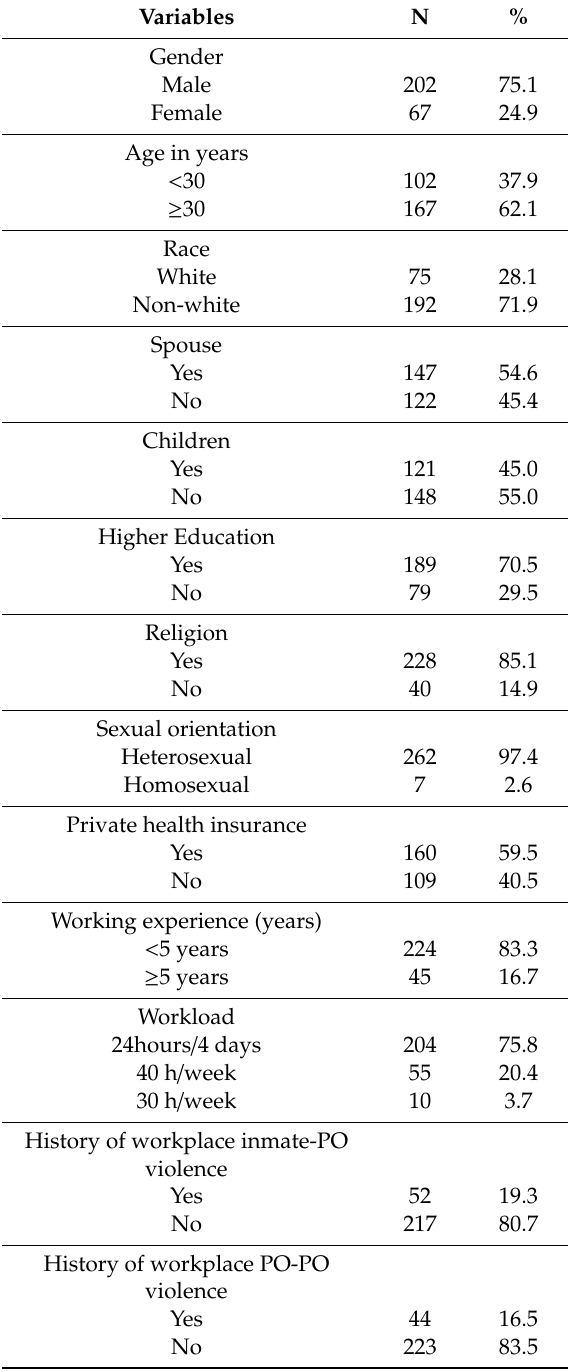
Table 1. Sociodemographic and work characteristics of prison o ffi cers (n =